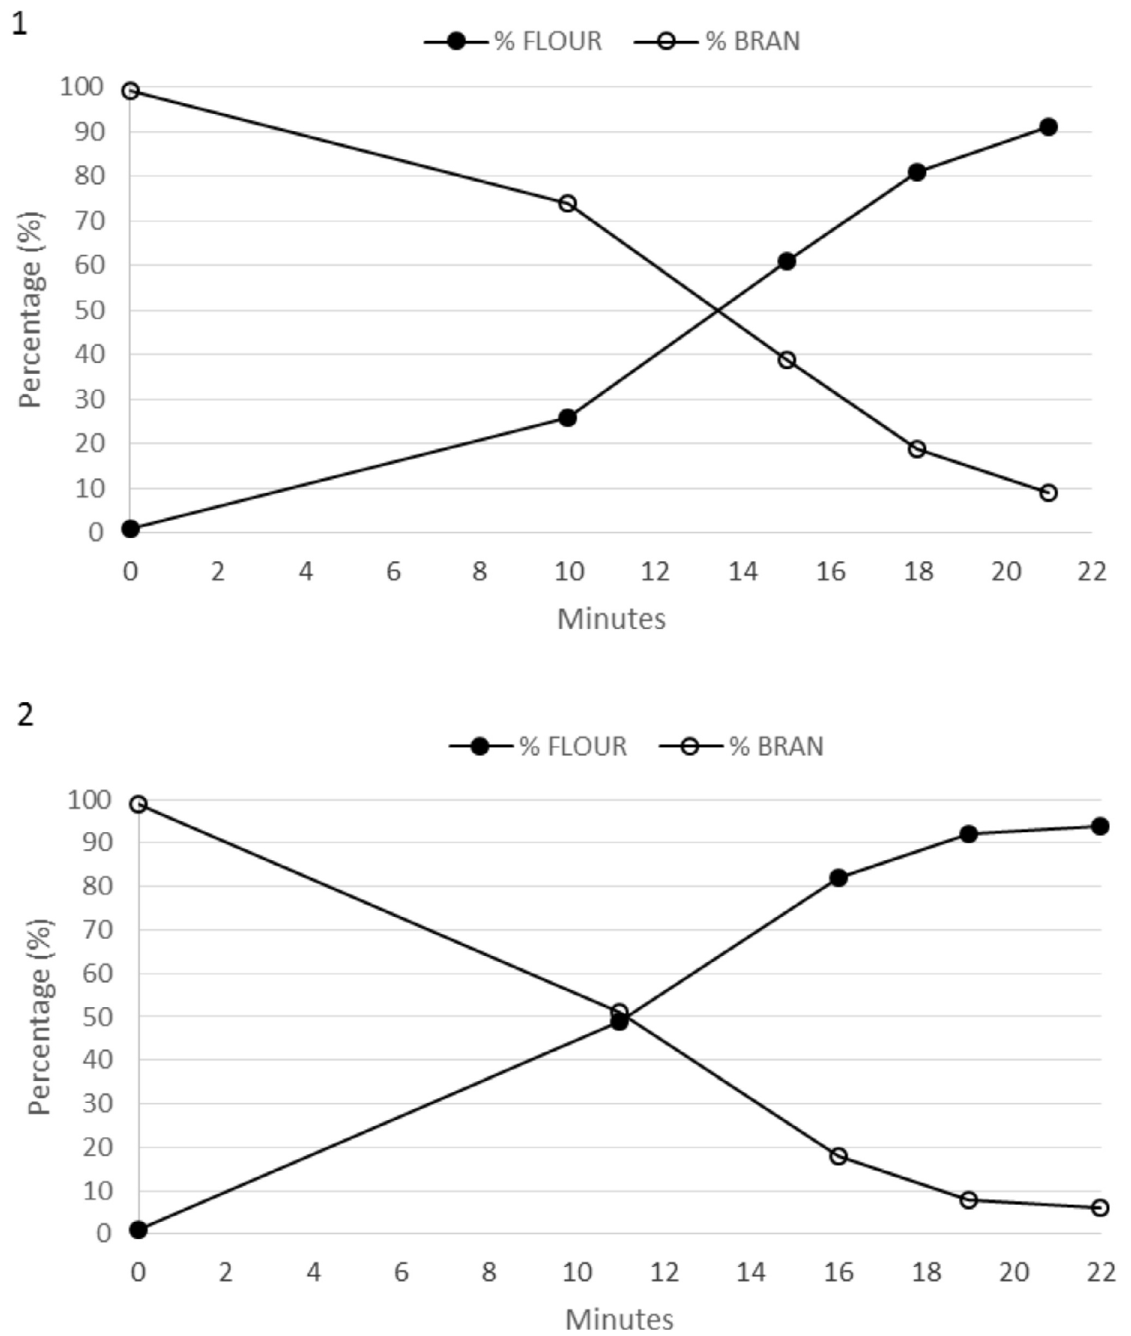
Figure 3. Experimental grain yield using (1) a handstone and (2) a wooden rubber. Values show the amount of flour against grain and bran (based on Risch 2002: 119, fig.